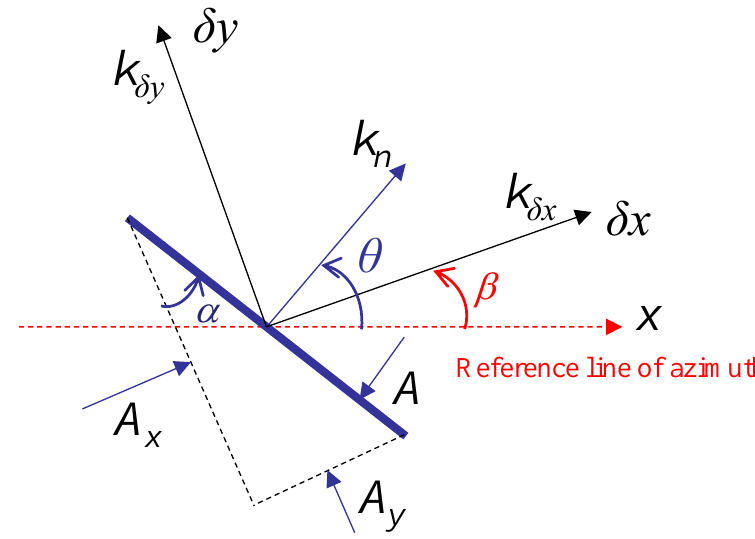
Figure A2. Schematic used to deduce the calculation model of permeability.